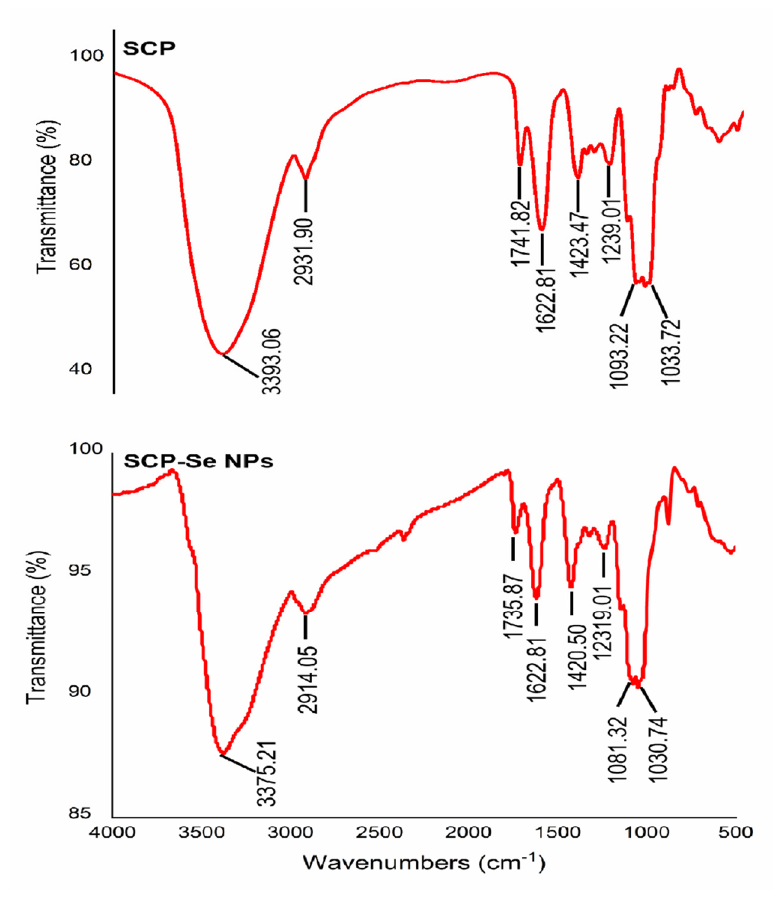
Figure 6. FTIR spectra of SCP and SCP-Se NPs.